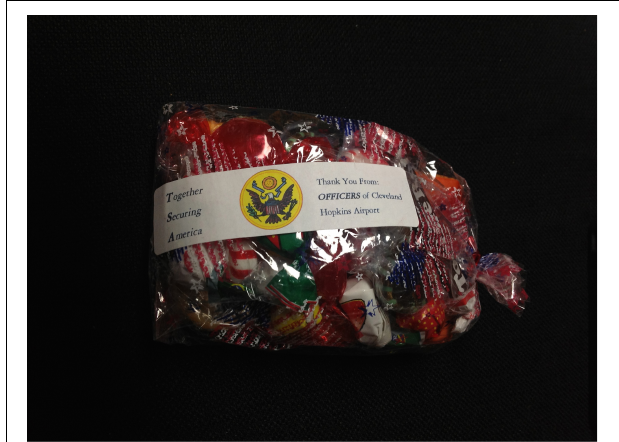
FIGURE 1 | Gift given to George by TSA personnel. This is a photo of the snack gift George received from screeners. He photographed it himself, and shared it unprompted, along with his airport security diaries. It says (left) “ T ogether S ecuring A merica” and (right) “Thank You From: OFFICERS of Cleveland Hopkins Airport.” The center image is the United States’ coat of